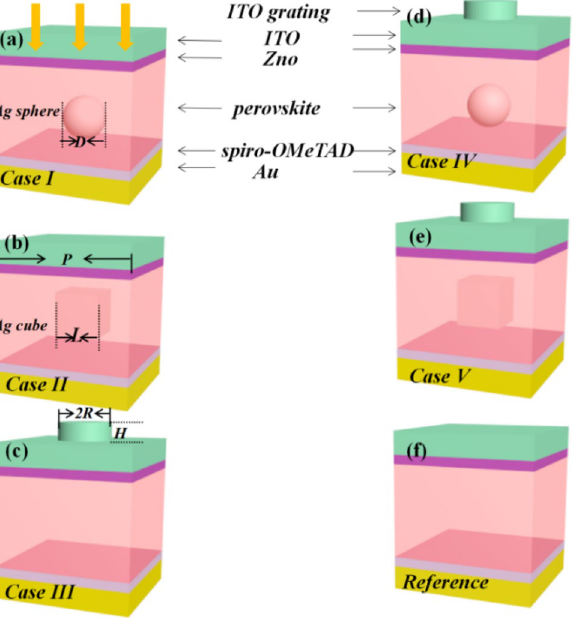
Figure 1. 3D schematic of the unit cell geometries of different types of perovskite solar cells proposed